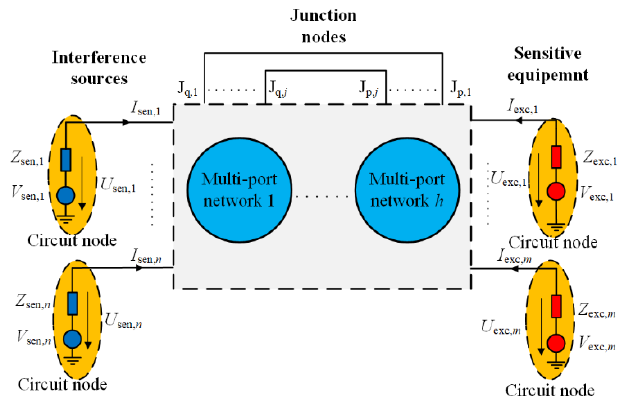
Figure 3. Global multi-port network.